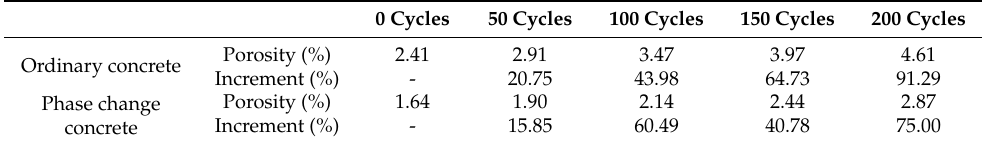
Table 14. Change of porosity in concrete during freeze–thaw process.